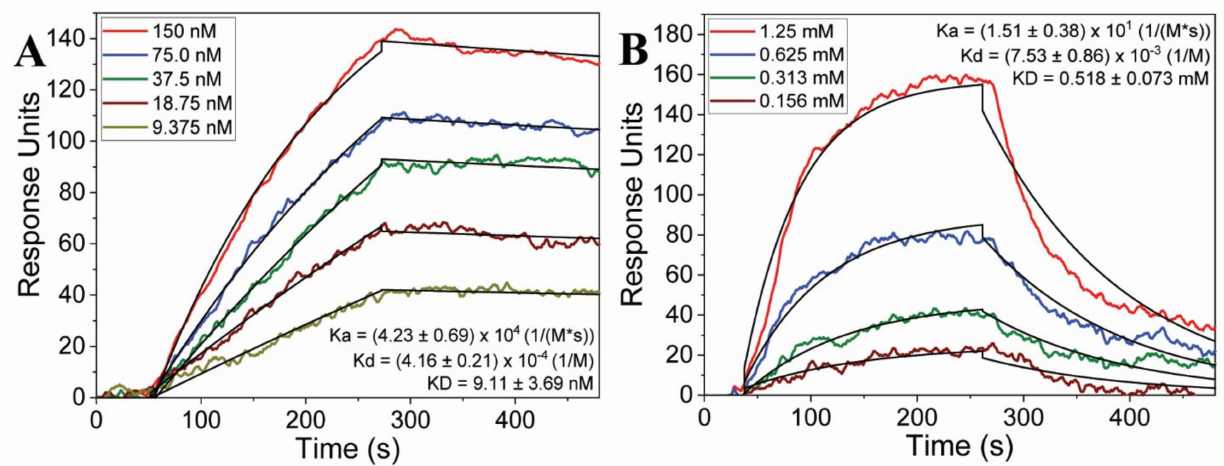
Figure 3. ( A ) Binding kinetics between spike glycoprotein and ACE2, and ( B ) kinetics measuring the binding between the spike protein and Peptide 3. The fit lines are shown in black for each curve, and the binding kinetics values (Ka, Kd, and KD) for each sample series are provided.